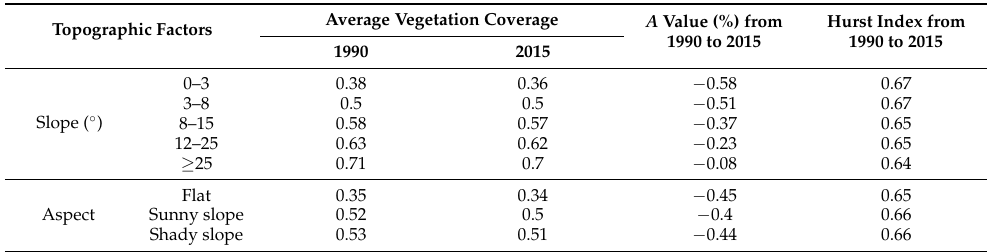
Table 2. Vegetation coverage and its variation characteristics on the Qinghai–Tibet Plateau under different terrain